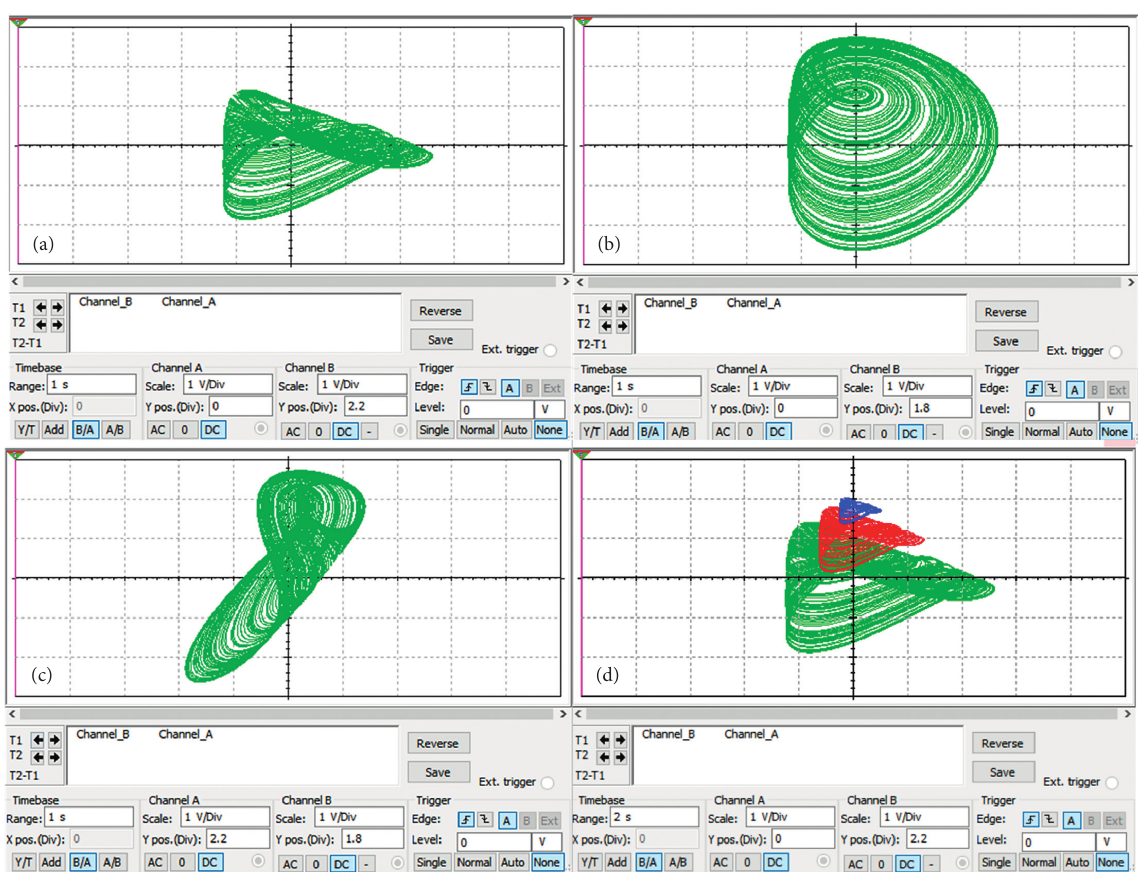
Figure 5: Chaotic attractor of system (1): (a) ( x )-( y ), (b) ( x )-( z ), (c) ( y )-( z ), and (d) the attractor changes due to the difference of R